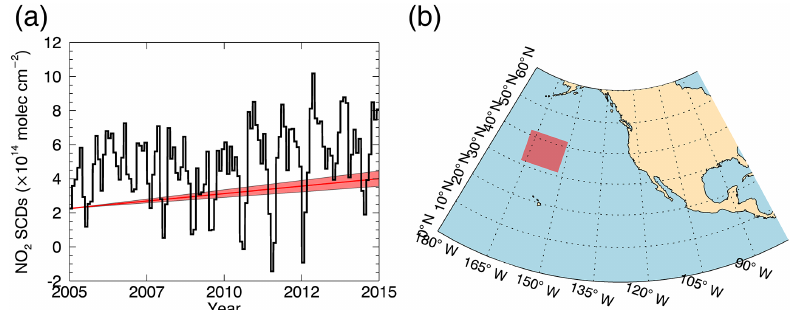
Figure 2. The black line in panel (a) shows the monthly averaged OMI tropospheric NO 2 VCD values in the North Pacific region (red box in panel b ) from 2005 to 2014. The red line in panel (a) represents the ocean trend used in this research, with the 95th-percentile confidence intervals shaded in